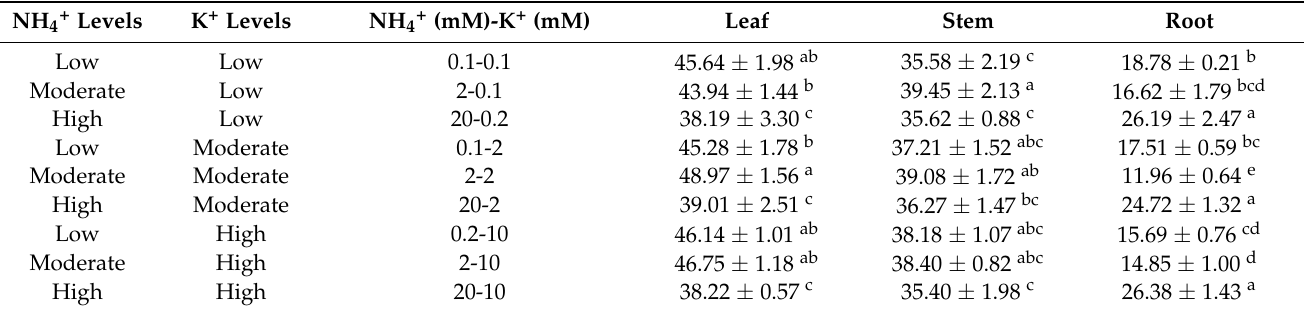
Table 6. Proportion of starch in leaves, stems, and roots (%) of tobacco seedlings under different NH 4+ and K +